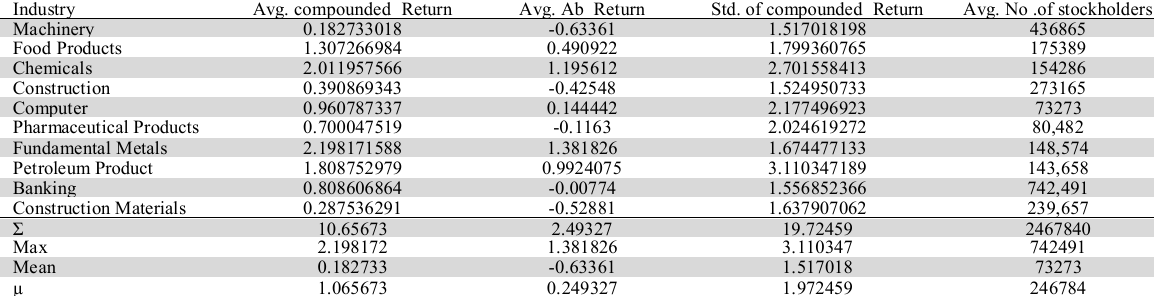
Industries return time series descriptive statistics